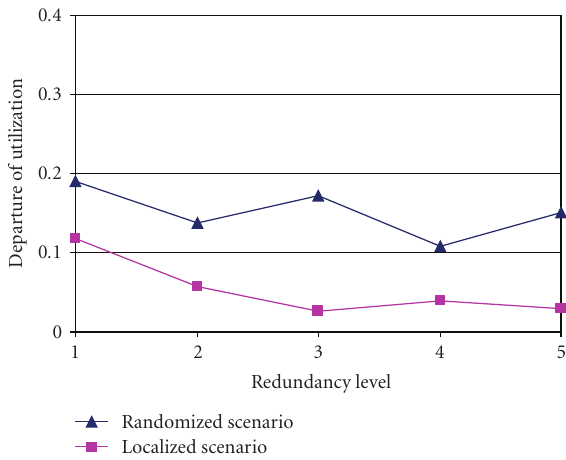
Figure 5: Upper Utilization—Heavily Loaded network.